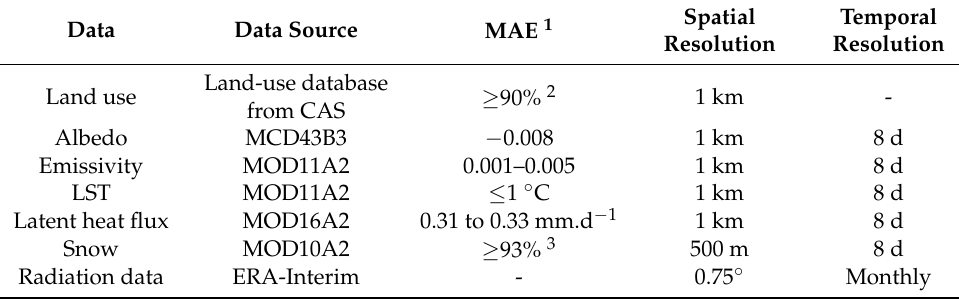
Table 2. Accuracy range and resolution of the main